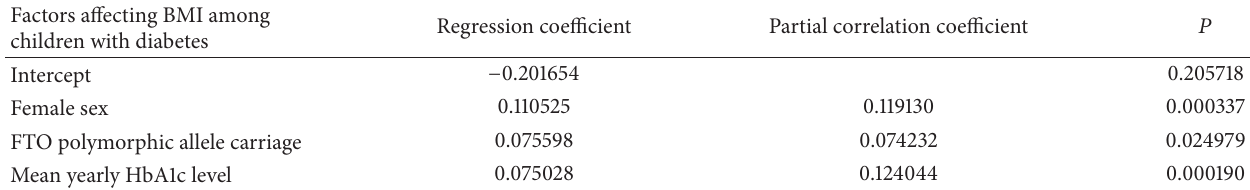
Table 2: Multivariate regression model including the clinical and genetic features influencing the standardized body mass index in children with type 1